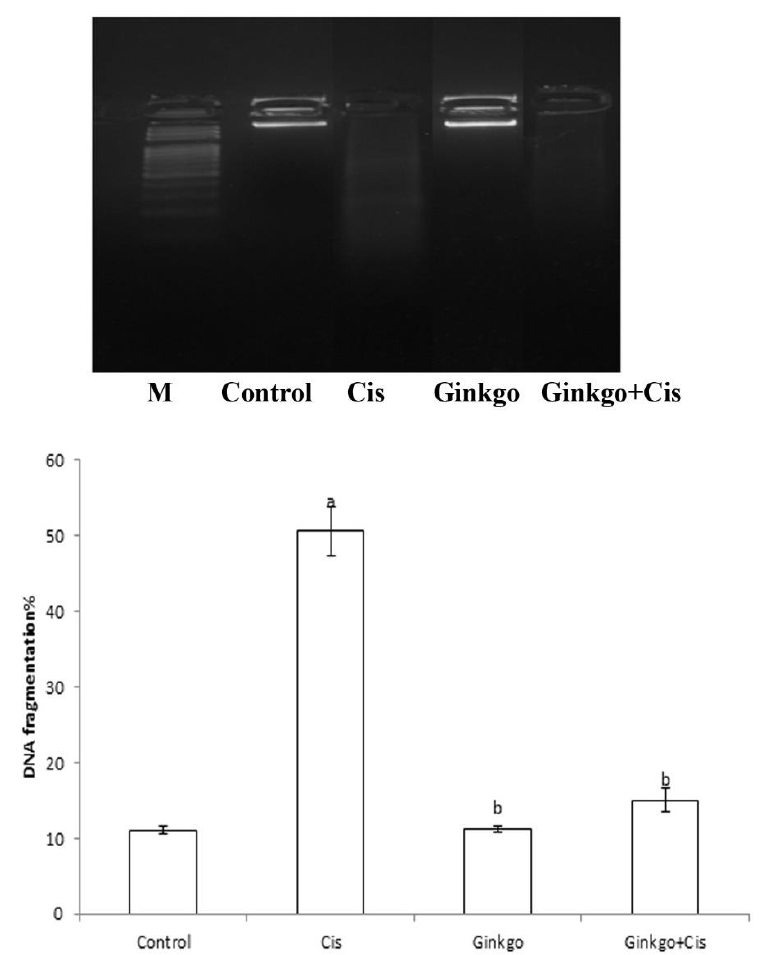
Figure 6. The changes of DNA fragmentation% in different groups. The effect of Cis, Ginkgo , and their combination on the expression level of DNA fragmentation% in rat brain tissues. Data present as mean ± SE ( n = 10). a indicates a significant difference compared to control group, b indicates a significant change compared to Cis group. a and b indicate statistical significance at p < 0.05 using ANOVA followed by Tukey–Kramer as a post ANOVA test.